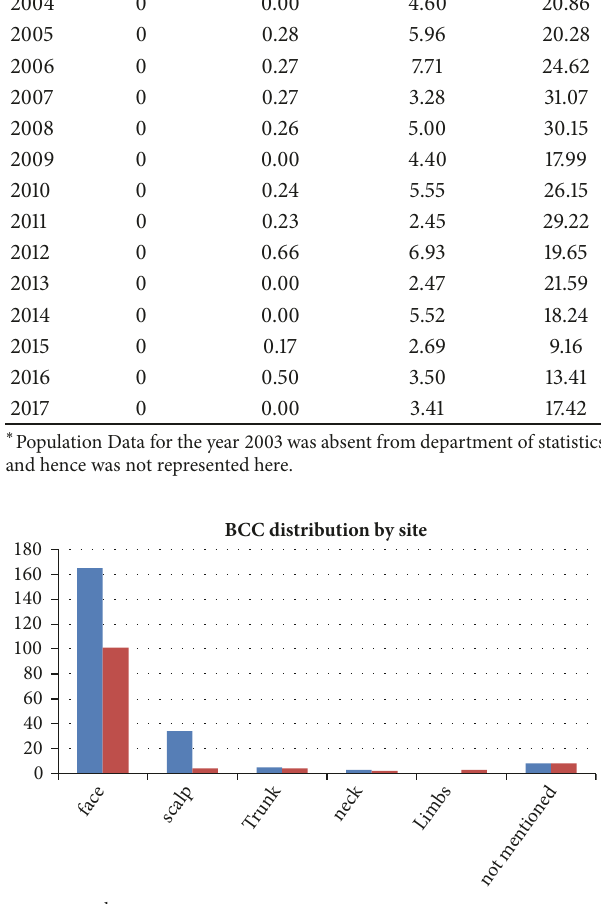
Table 1: Age adjusted incidence rates for BCC per 100,000 popula- tion (2004-2017) ∗ .